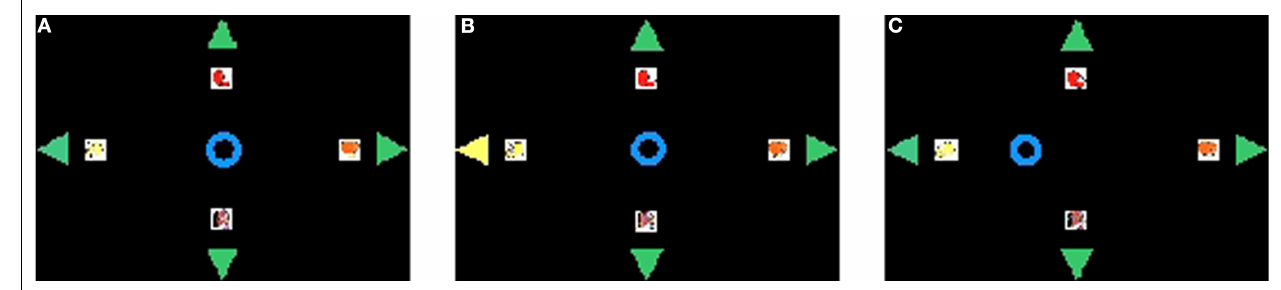
FIGURE 2 | Graphics during a single trial. (A) the cursor, the target-icons and the four arrows; (B) the fl ashing arrow; (C) the movement of the cursor after P300 recognition.